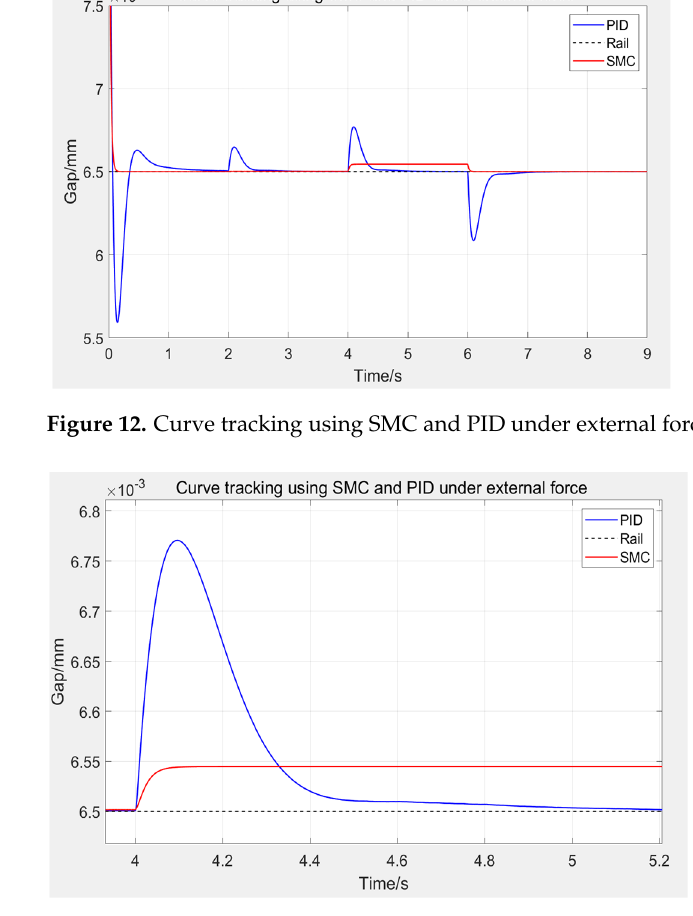
Figure 13. Curve tracking enlarged view of SMC and PID algorithm under external force.